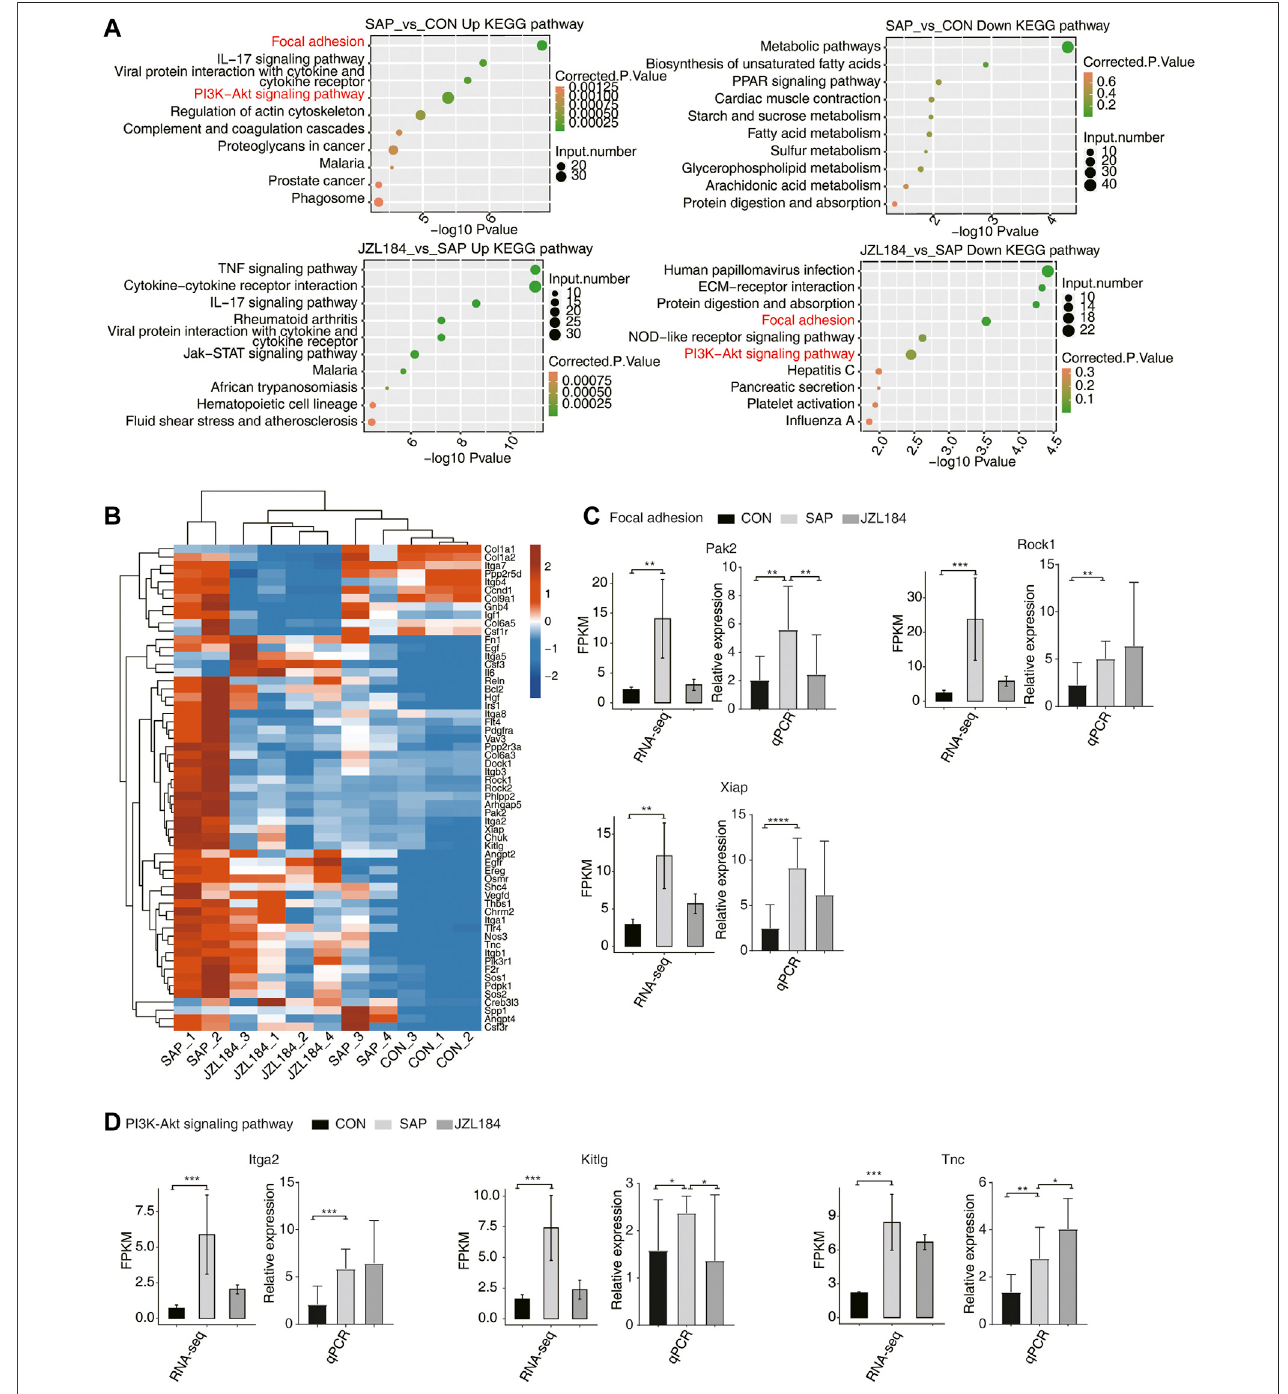
FIGURE 3 | MAGLinhibitorextensivelychangealternativesplicingpatternofgenesinintestinaltissueofratswithSAP. (A) BubbleplotshowingthetoptenenrichedKEGG terms for up regulated (Left panel) and down regulated (Right panel) DEGs. The downregulated genes in the SAP group were mainly enriched in human papillomavirus infection, ECM receptor interaction, protein digestion and absorption, focal adhesion, nod-like receptor signaling pathway, PI3K-Akt signaling pathway, hepatitis C, pancreatic secretion, plateletactivation,andin fl uenza (A,B) .HierarchicalclusteringheatmapshowingtheexpressionlevelsofallgenesonFocaladhesionandPI3K-AktsignalingpathwayinTop 10 in the KEGG analysis. The expression of Rock1, Rock2, Pak2, Xiap, Arhgap5, Itga2, Tnc, Dock1, Col6a3, Pdgfra, Chuk, Kitlg, Sos1, Ppp2r3a, and Phlpp2 was higher in the SAPgroupandlowerintheJZL184group; (C) BarplotshowingtheexpressionpatternandstatisticaldifferenceofDEGsforsomeimportantgenesinFocaladhesion.Errorbars representmean±SEM.TheexpressionofPak2,Rock1,andXiapwasincreasedintheSAPgroupcomparedwiththecontrolgroup,whichwasconsistentwithourexpectations. Moreover, expression of Pak2 and Xiap was decreased in the JZL184 group compared with the SAP group; *** p -value < 0.001, ** p -value < 0.01. (D) Bar plot showing the